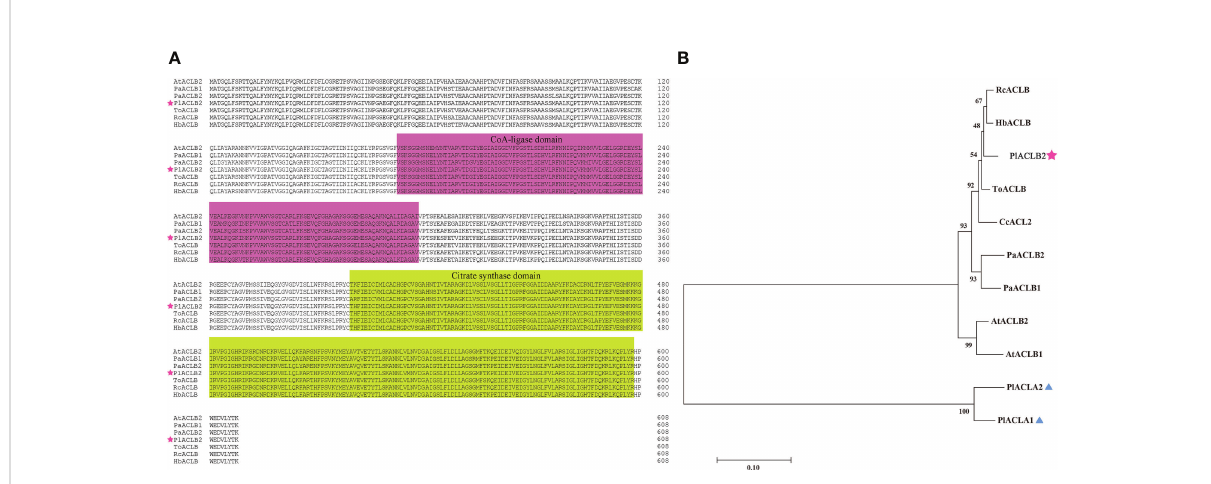
FIGURE 4 Amino acid sequence alignment and phylogenetic analysis of PlACLB2 and other ACL proteins. (A) Multiple sequence alignment of the amino acid sequence of PlACLB2 with ACL proteins from other plants. PlACLB2 isolated from P. lacti fl ora was marked with a pentagram. The distinct parts indicate conserved CoA-ligase and citrate synthase domains. (B) A phylogenetic tree of PlACLB2 and other ACL proteins in other plants. PlACLB2 was indicated with a pentagram. All these protein sequences were downloaded from NCBI and their GenBank IDs are as follows: HbACLB (XP_021653557.1, Hevea brasiliensis ), RcACLB (XP_015574748.1, Ricinus communis ), ToACLB (PON93182.1, Trema orientale ), CcACL2 (XP_006419381, Citrus clementina ), PaACLB1 (Peaxi162Scf00228g00327.1, Petunia axillaris ), PaACLB2 (Peaxi162Scf01160g00016.1, Petunia axillaris ), AtACLB1 (NP_001326324.1, Arabidopsis thaliana ), AtACLB2 (NP_001332247.1, Arabidopsis thaliana